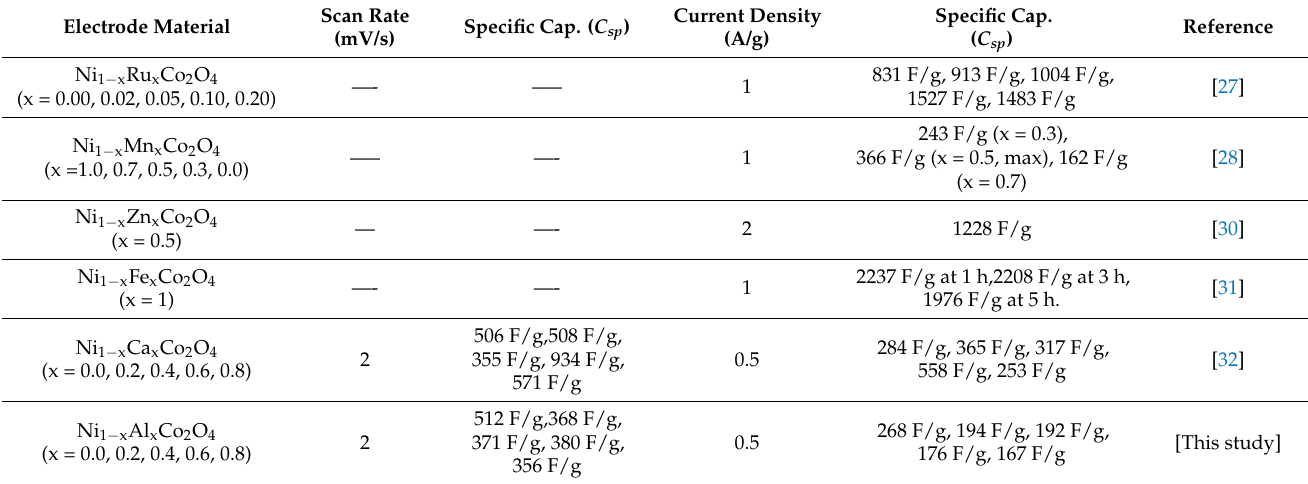
Figure 8. ( a ) Ragone plot of power density vs. energy density, ( b ) frequency-dependent real impedance measured, and ( c ) Nyquist plot for Ni 1 − x Al x Co 2 O 4 at open circuit potential obtained in 3M KOH electrolytes. Table 5. Comparison of specific capacitance of electrodes derived from doping of transition elements on NiCo 2 O 4 using the hydrothermal method.